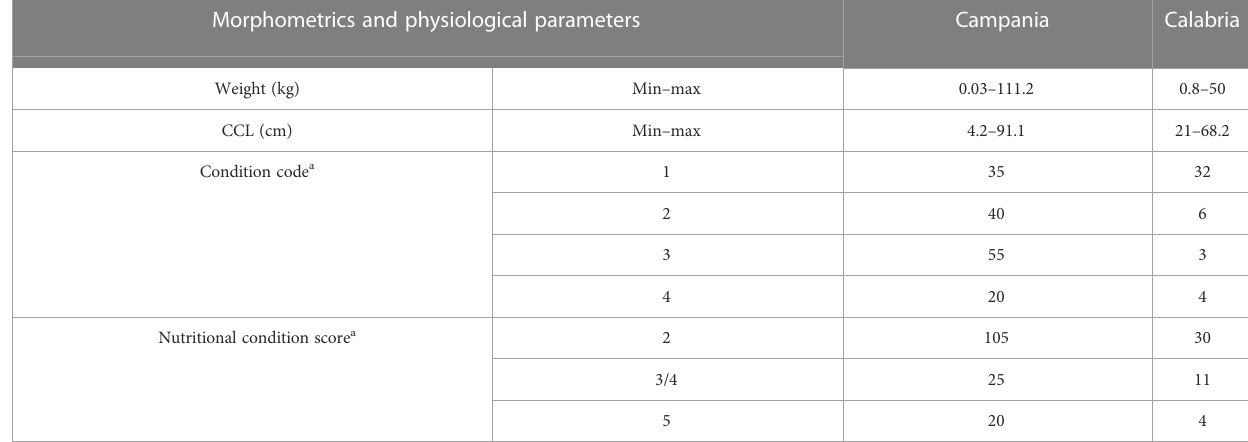
TABLE 2 Morphometrics and physiological parameters evaluated during necropsy in the Campania and Calabria